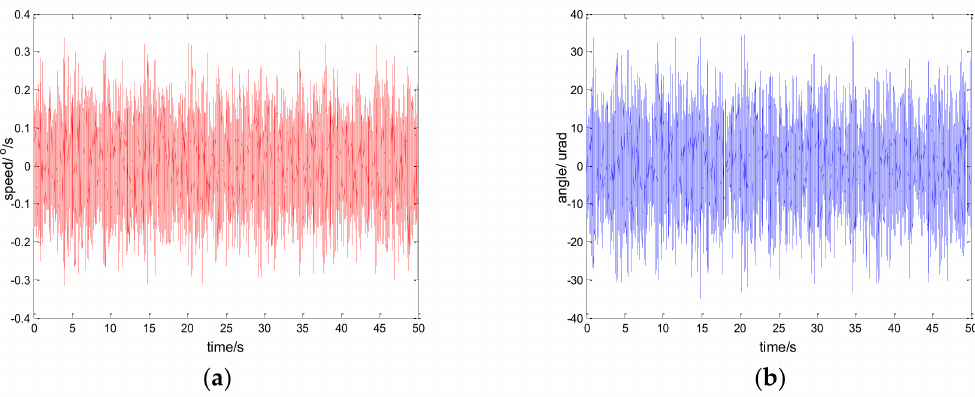
Figure 22. Robustness experiment results of robust SMC with NTD. d = 3sin ( 2 π × 0.1 t ) : ( a ) speed; and ( b ) tracking error, RMS = 9.9620 urad.